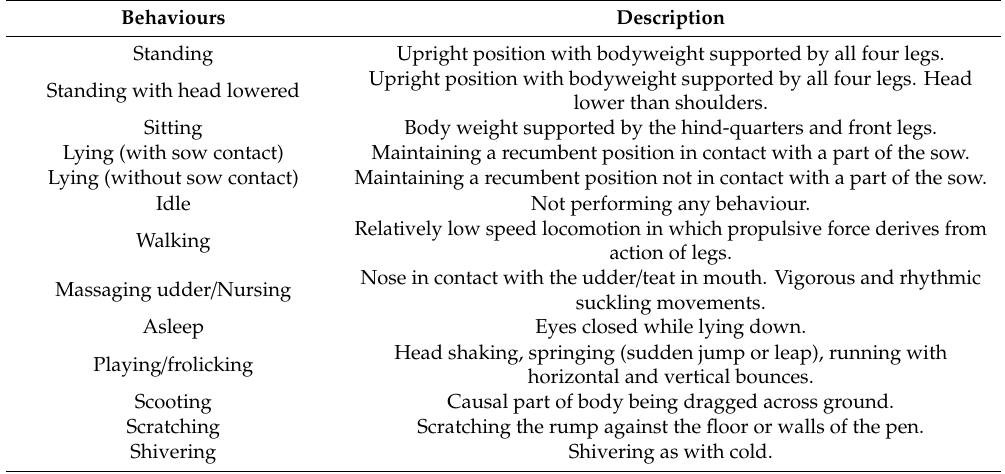
Table1. Descriptionsofthepigletbehavioursobserved(modifiedfromHayetal. andHurnick et al. [12,22]). Behaviours